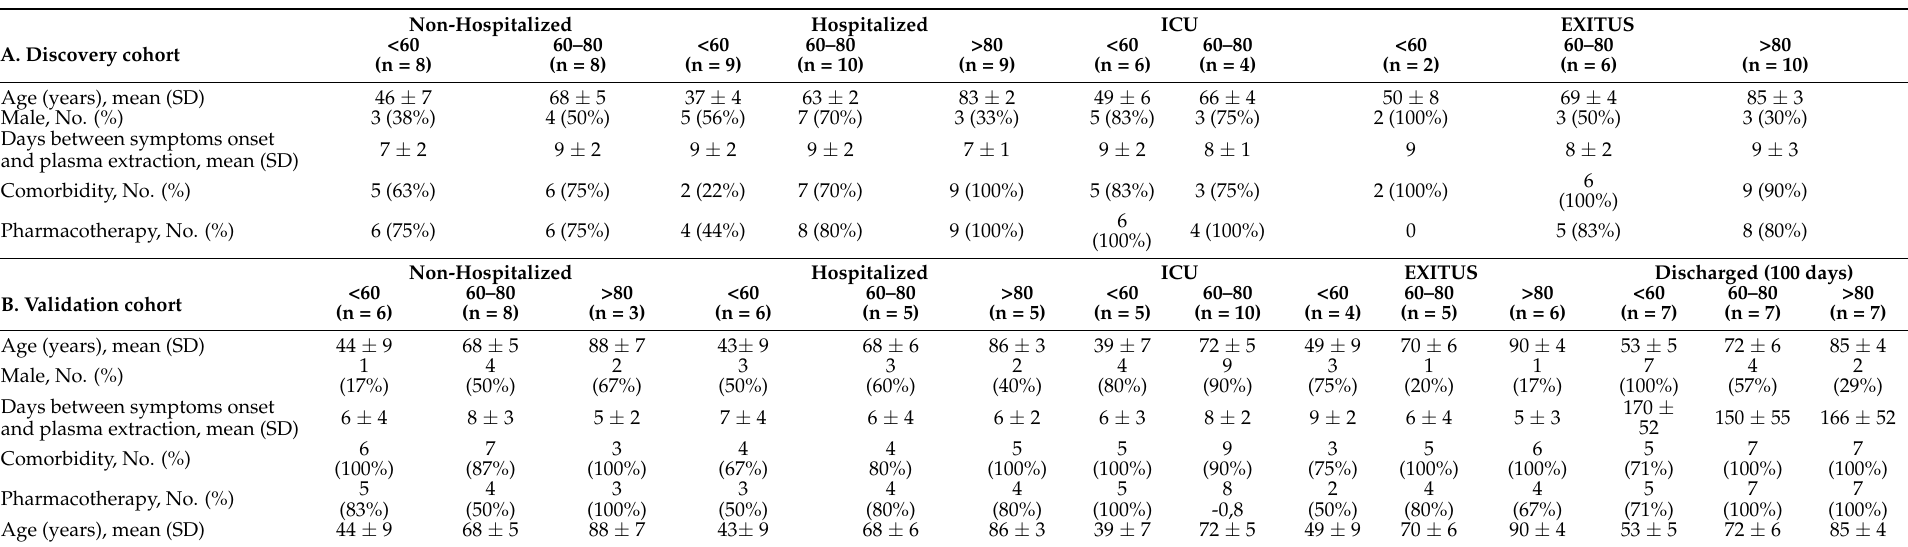
Table 1. Characteristics of discovery and validation